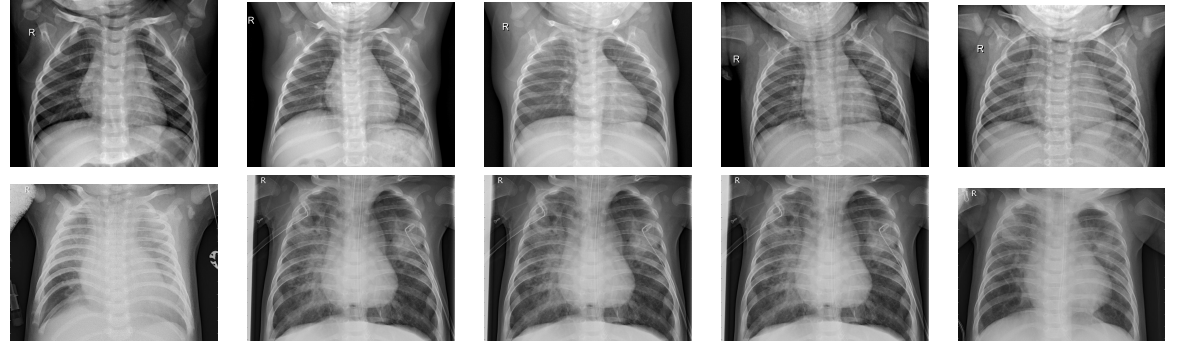
Figure 5. Sample images from the chest X-ray (pneumonia) dataset. The images are divided into two categories: Normal, and